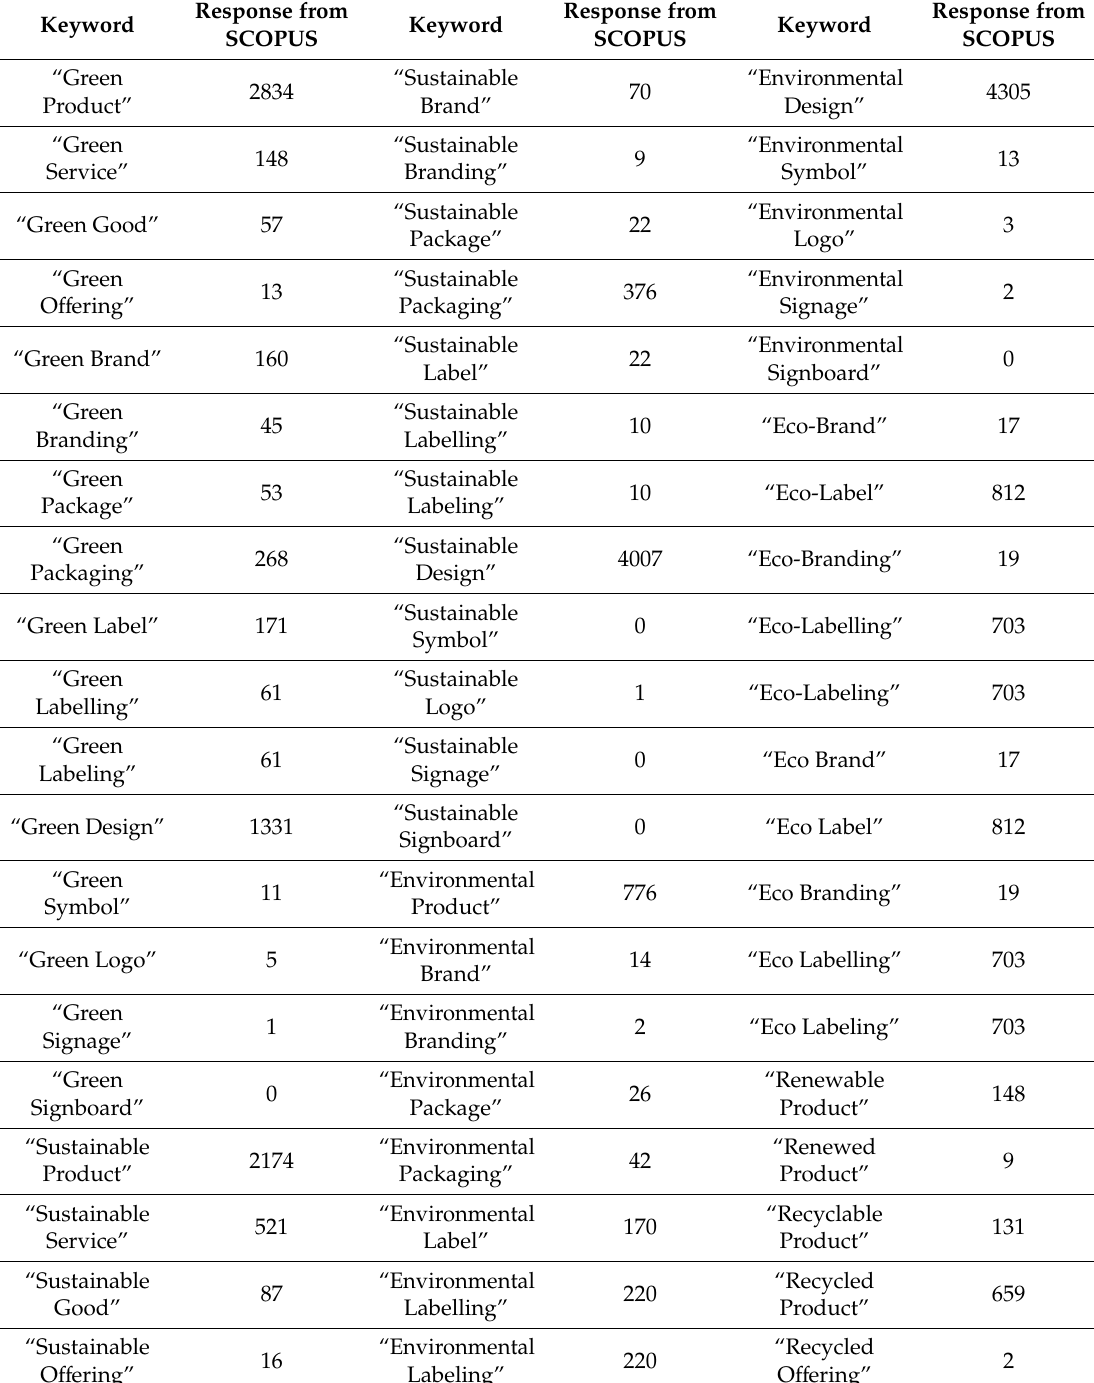
Table 1. Keyword phrases related to the green